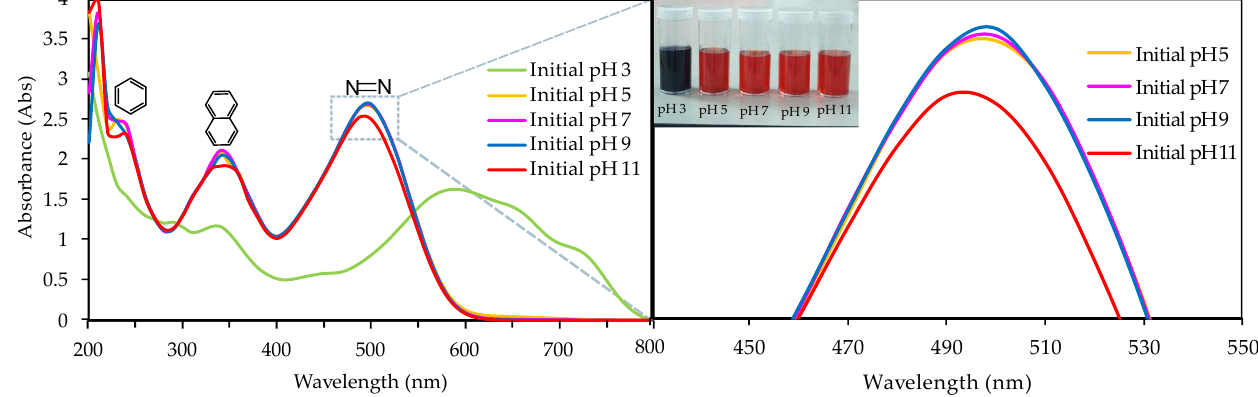
Figure 1. The UV – Vis spectra of diazo Congo red dye at different initial pH values. Inset: Photo of the dye solution at different initial pH conditions.